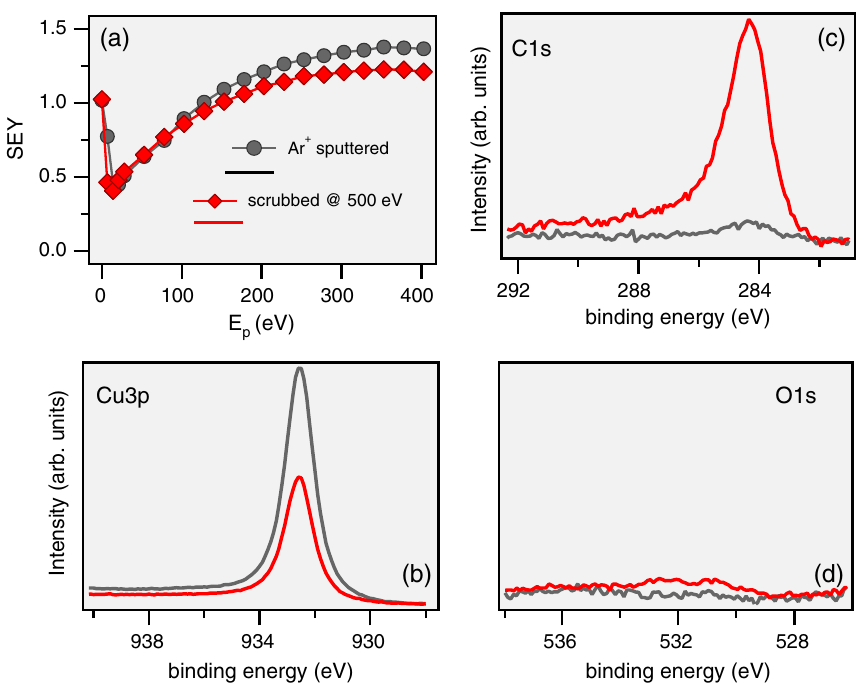
FIG. 3. (a) SEY curves measured on the colaminated Cu sample for LHC beam screen cleaned by Ar þ sputtering (grey circles) and after the subsequent scrubbing with 500 eV electrons ( 10 (cid:2) A , Q ¼ 3 : 6 (cid:3) 10 (cid:1) 2 C = mm 2 ) (red diamonds); (b)–(d) Cu2p O1s core level spectra measured on the Ar þ sputtered (grey lines) and on the scrubbed surface (red lines).